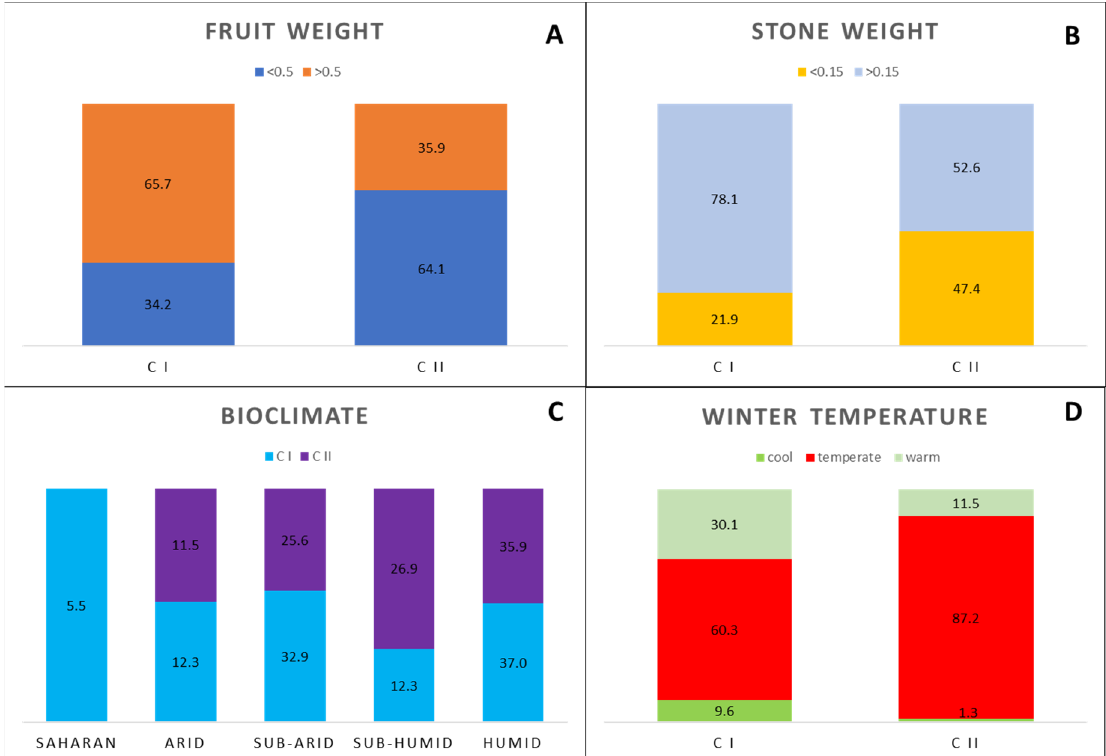
Figure 6. Histogram illustrating the % of olive samples included in clusters I and cluster II of the dendrogram, considering the traits fruit ( A ) and stone ( B ), and the climatic factors ( C , D ).